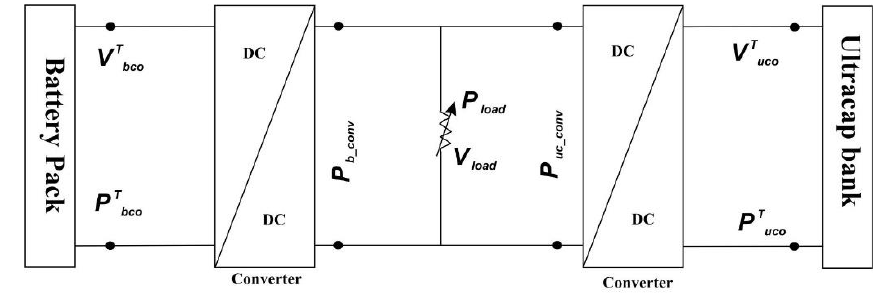
Figure 7. Multiple converter configuration diagram.